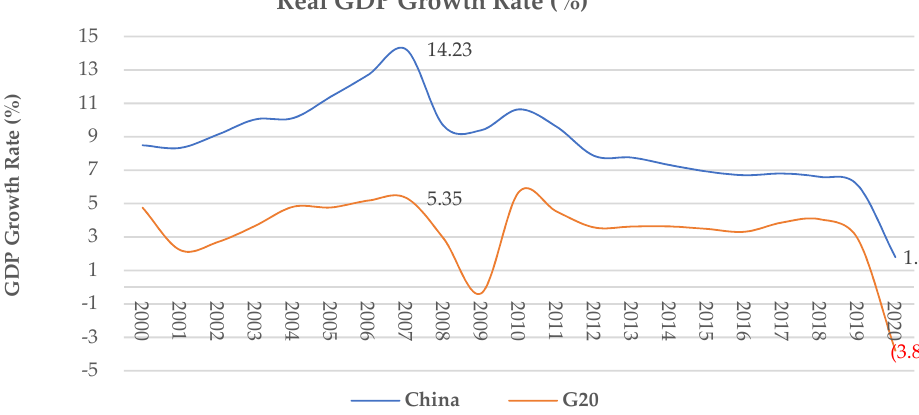
Figure 6. Real GDP growth rate of China compared with the G20. Source: OECD [2,67].